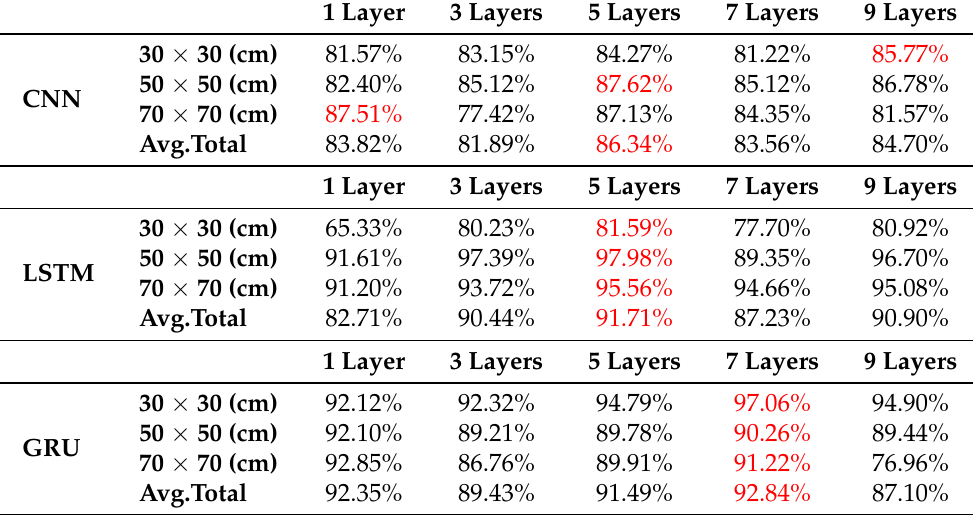
Table 2. 40 cm distance between the steel plate and sensor. Red is the best performance.